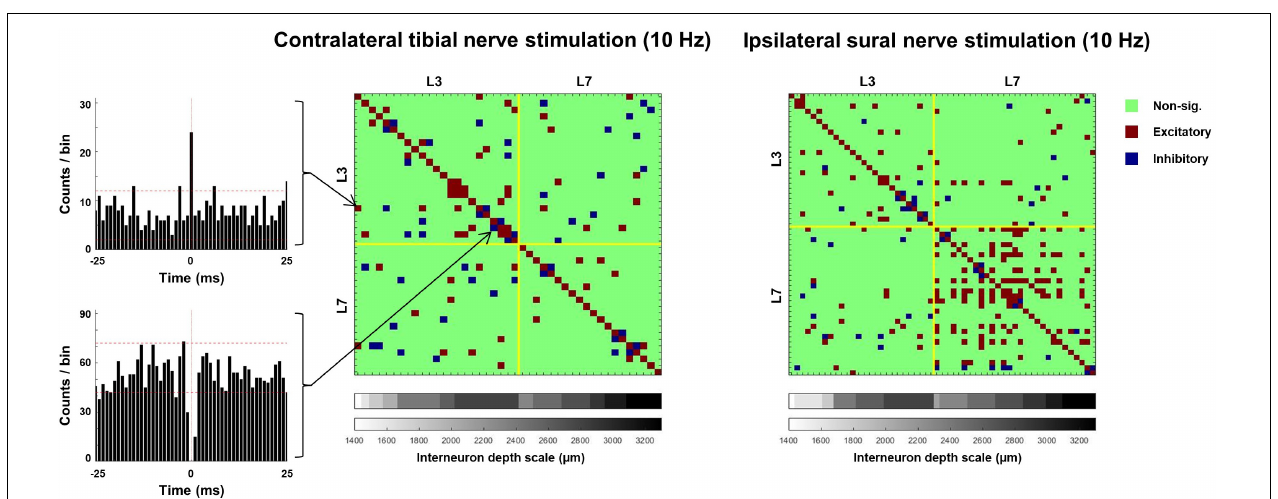
FIGURE 10 | Matrices illustrating the incidence of significant excitatory and inhibitory synchrony between interneurons during exemplar trials of tibial (left) and sural (right) nerve stimulation. PSTHs illustrate exemplar pairs of interneurons displaying excitatory (top) and inhibitory (bottom) synchrony. Dashed horizontal lines on PSTHs represent 95% confidence intervals calculated from a 15 ms pre-stimulus period.